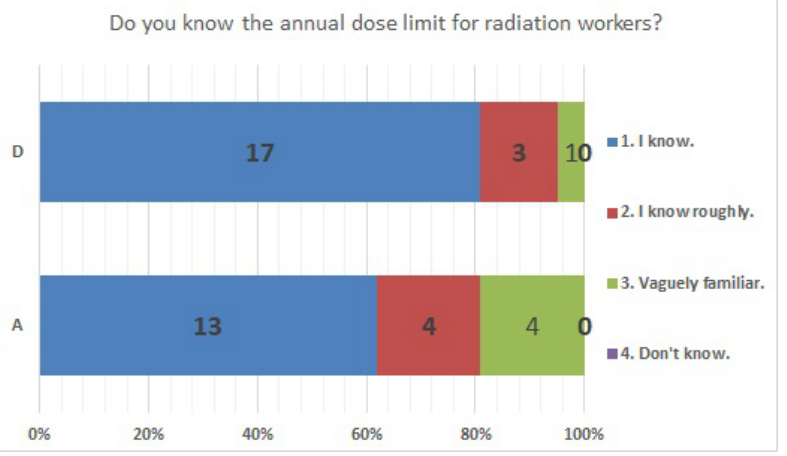
Figure 19. Responses to item No. 30.